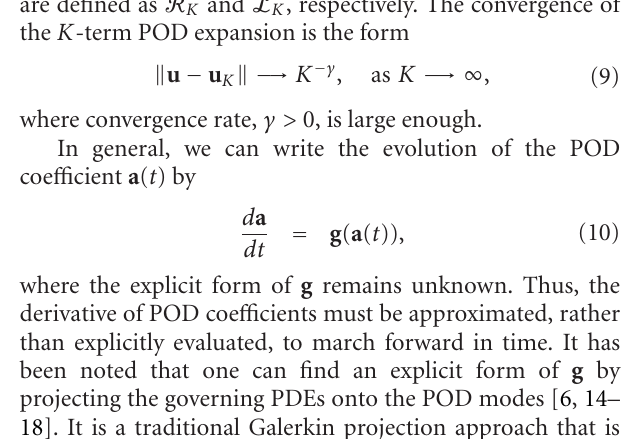
these processes by two operators: a restriction operator R